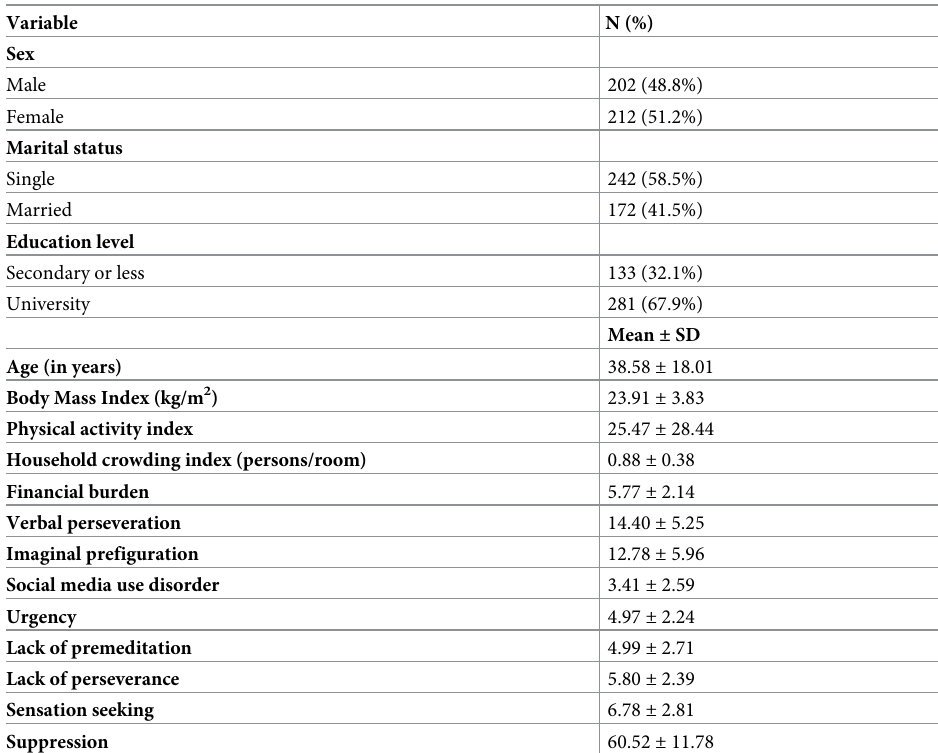
Table 1. Sociodemographic and other characteristics of the participants (N =